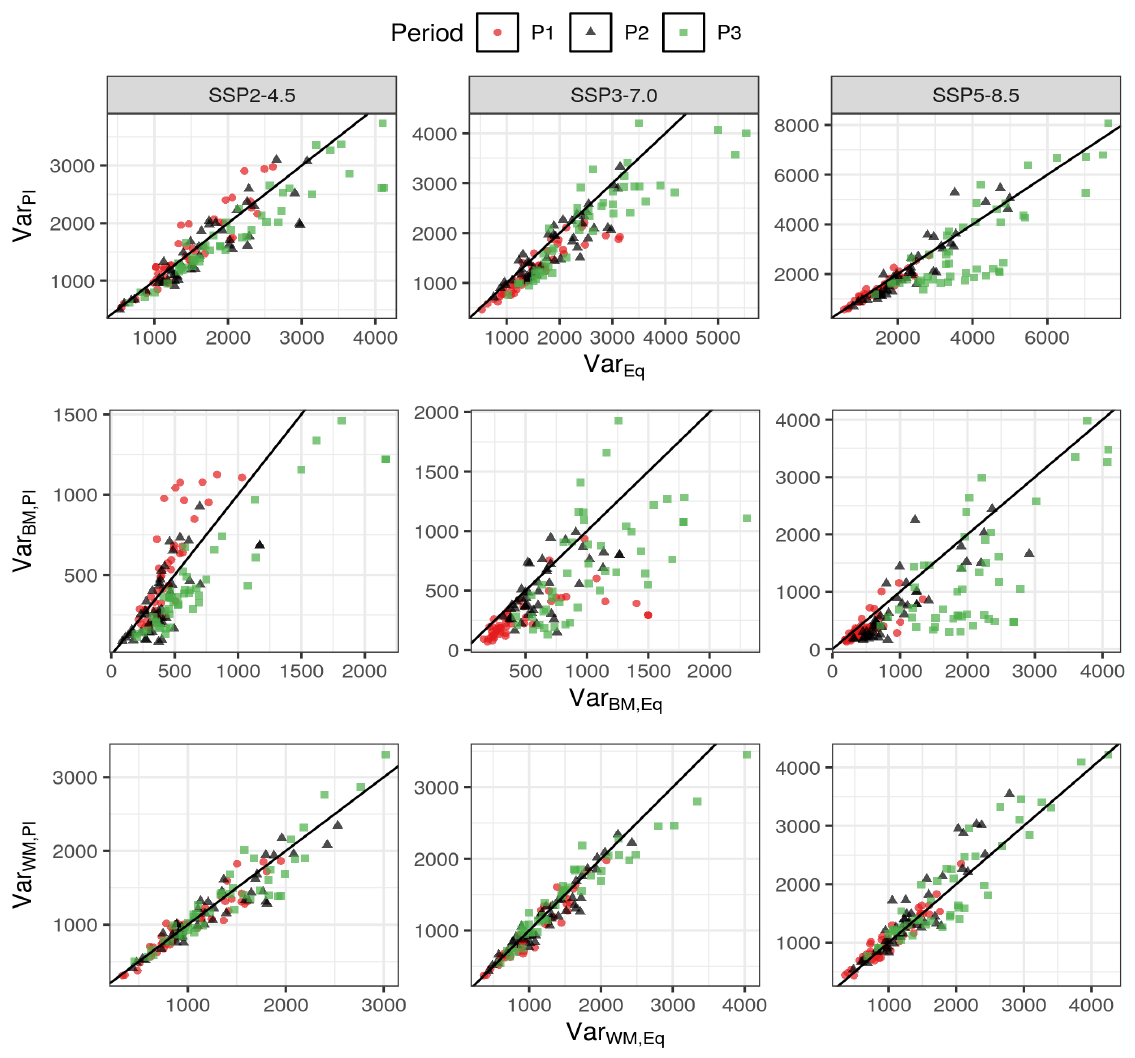
Figure 14. Scatter plot showing the differences of variances of the 20-year return levels calculated from the PI-weights and the equal weights, plotted for 46 grid points in the Korean peninsula for each future period and for each scenario. Var PI for the Y-axes (top panel) is the variance calculated by (13) from the PI-weights, and Var BM , PI (middle panel) and Var WM , PI (bottom) are the between-model and within-model variances, respectively. Var Eq , Var BM , Eq , and Var WM , Eq for the X-axis are the corresponding variances calculated from the equal weights. The value on each point in the top panel is a sum of those in the middle and in the bottom